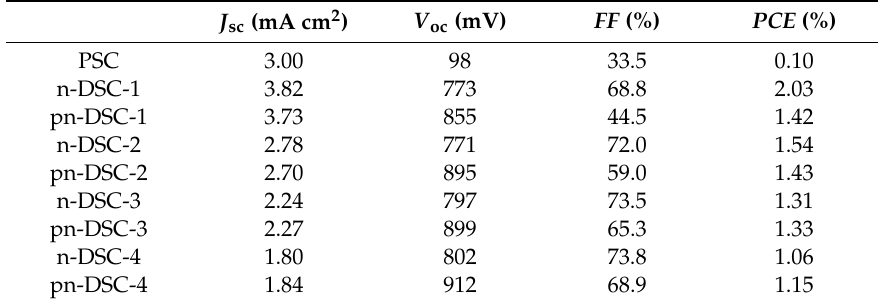
Figure 5. ( a ) J-V curve of the pn-DSC with different photoanode; ( b ) J-V curve of the corresponding n-DSC and p-DSC. Table 2. Photovoltaic parameters of the experimental pn-DSCs as well as p-DSCs and